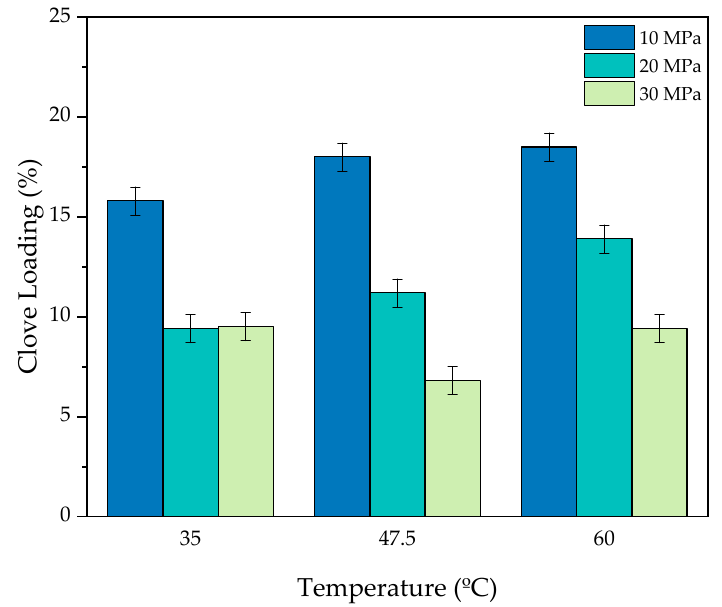
Figure 4. Influences of pressure (10–30 MPa) and temperature (35–60 °C) on the clove extract loading (CL%) in PC. Standard deviation of 0.7%.